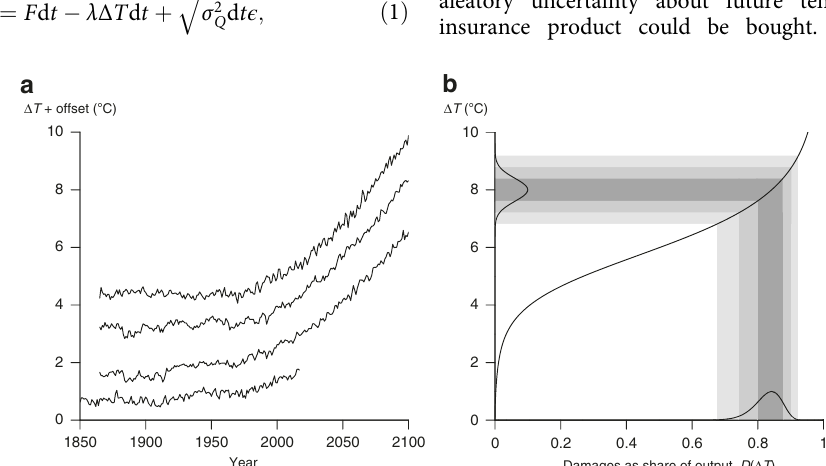
Fig. 1 Temperature variability results in uncertain climate damages. a Observed and global circulation model simulated temperature trajectories are plotted here to illustrate the inter-annual variability typically present. From bottom up, the plot includes HadCRUT (observation), run 9 of EC-EARTH-4, run 1 of ACCESS1-0, and run 1 of CMCC-CMS (the last three being members of the CMIP5 ensemble). The four time series are offset to make the nature of the variability easier to see. b Re fl ects an illustrative normal distribution of the global mean temperature anomaly ( μ = 8 and σ = 0.4) through Weitzman ’ s damage function 15 to obtain economic damages as a share of global economic output. The shading traces the ± σ range, ±2 σ , and ±3 σ of the temperature distribution, and shows that the damage distribution becomes left tailed when the expected value of global mean temperature is suf fi ciently high. It becomes right tailed when the expected value is